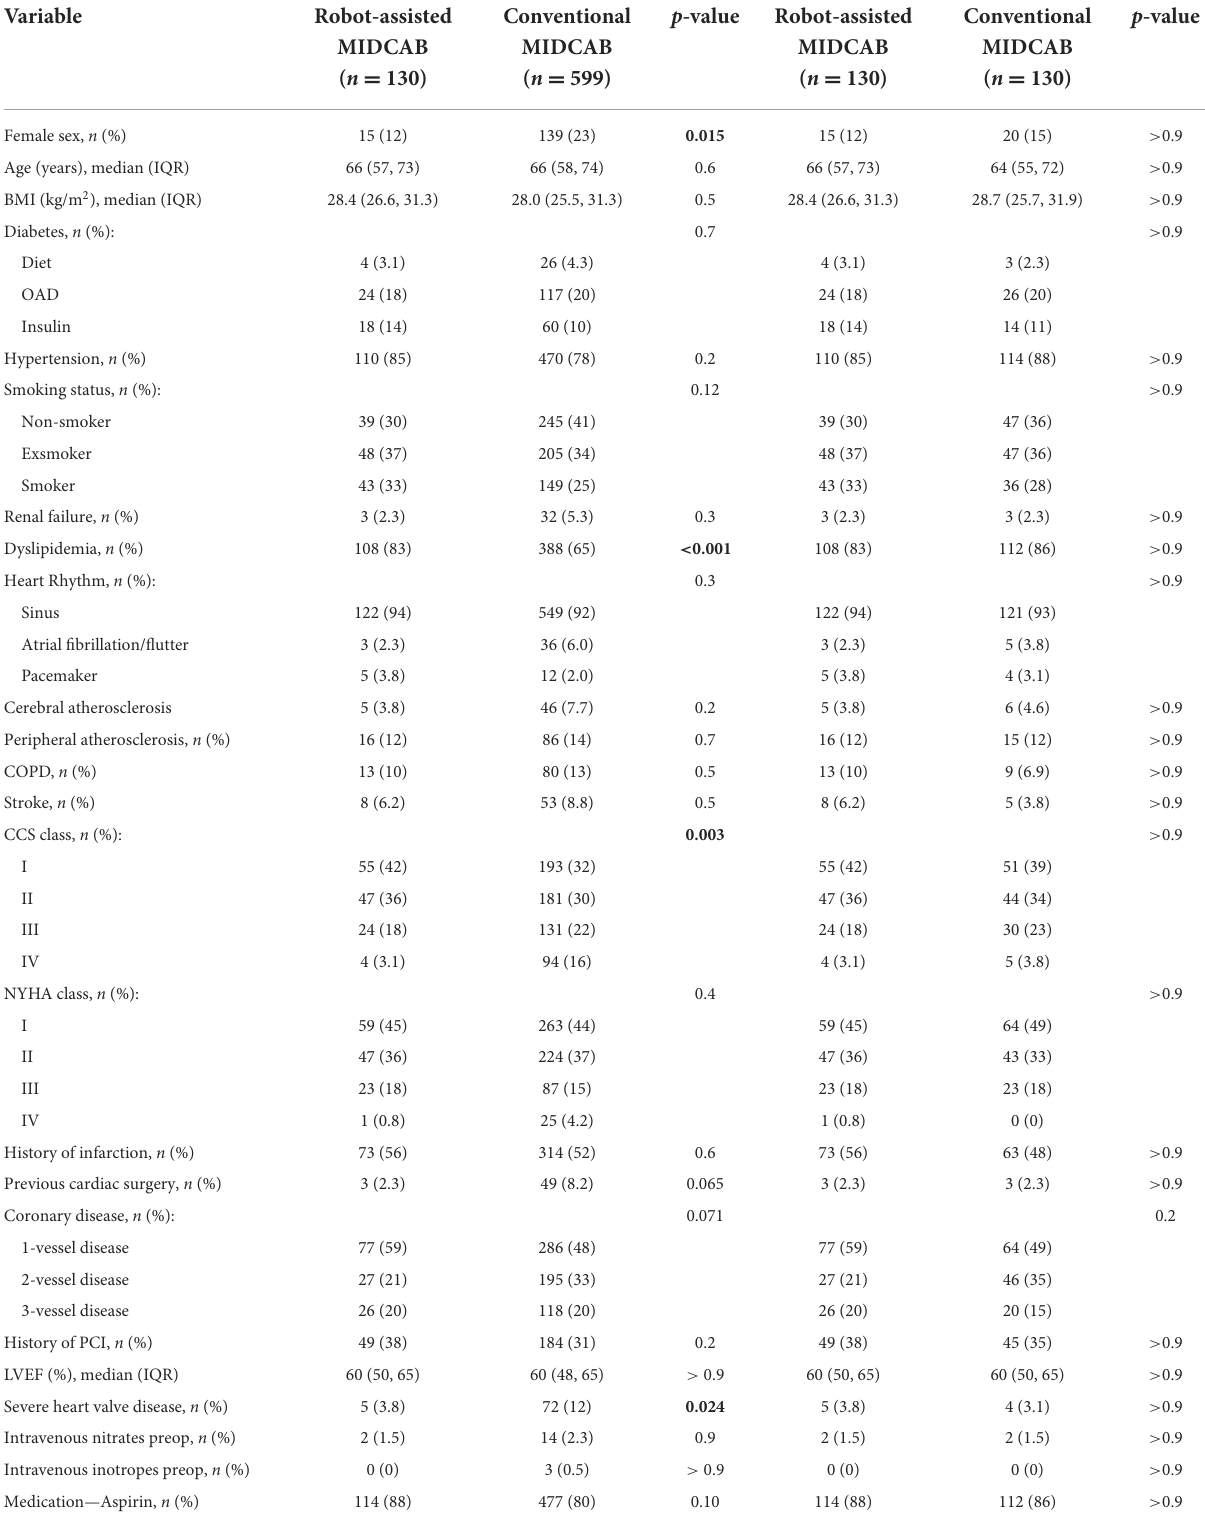
TABLE 1 Preoperative cohort characteristics pre- and